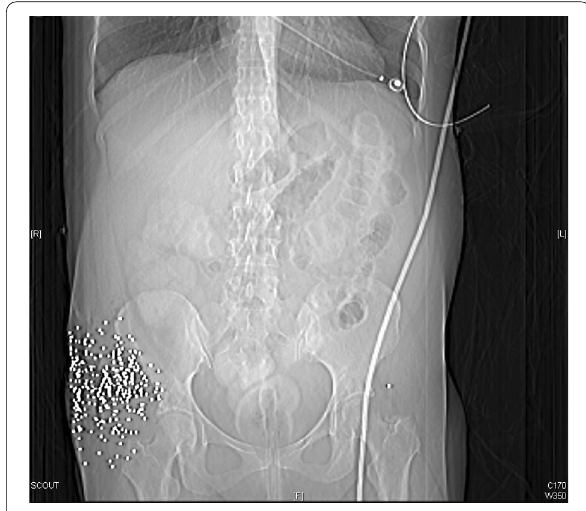
Fig. 4 Abdominal X-ray showing numerous shot pellets contained in a relatively small area near the patient’s right